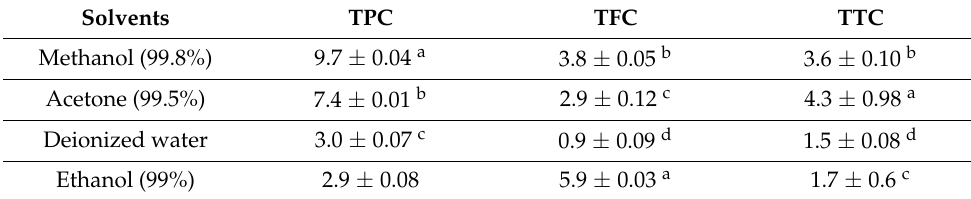
Table 1. Effect of different solvents on the extraction of TPC, TFC, and TTC from leaf extract of J. procera (mg/g